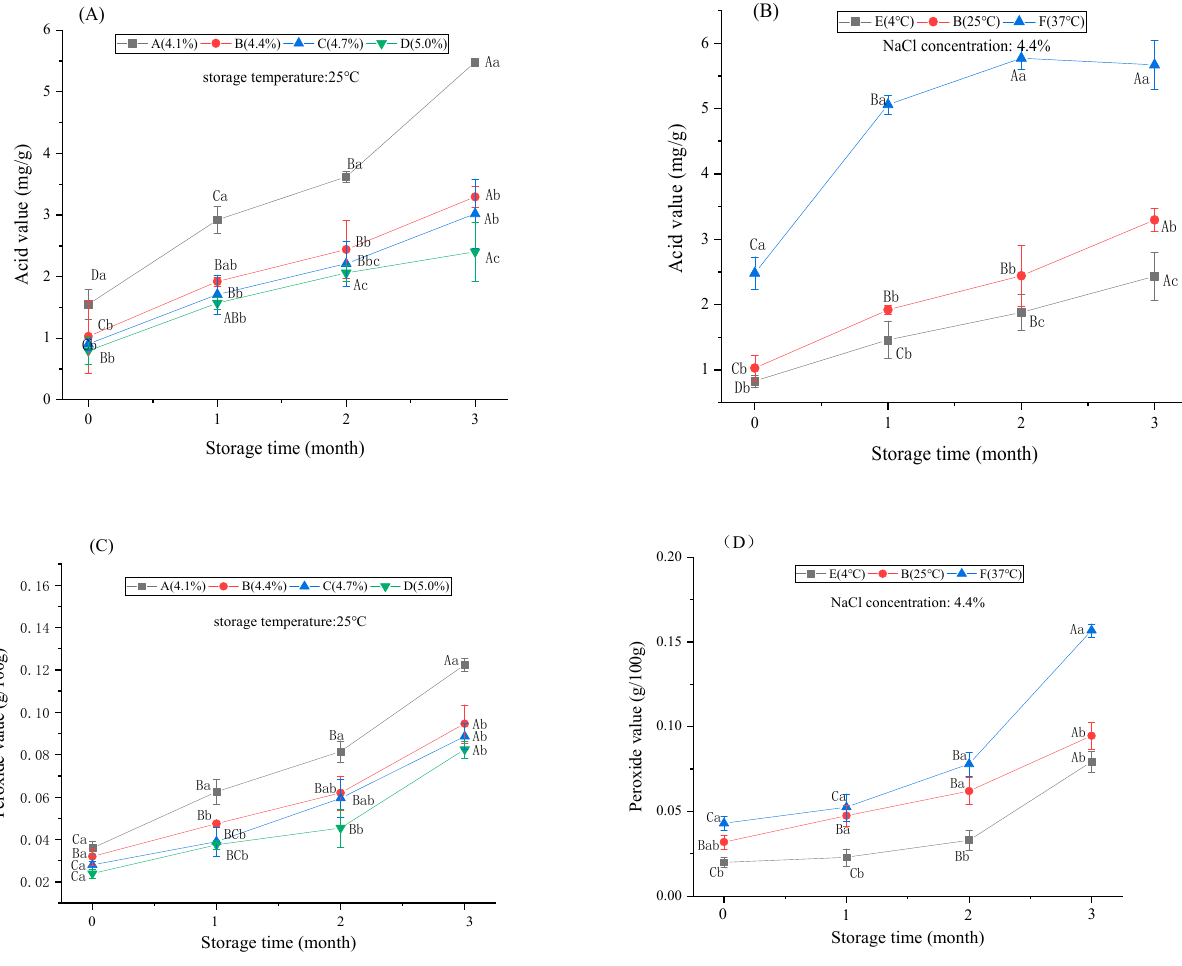
Figure 2. The influence of salt concentration and storage temperature on the AV and POV of hotpot sauce. ( A , C ) Comparison of AV ( A ), POV ( C ) of hotpot sauce with different salt concentrations during storage; ( B , D ) Effects of different storage temperatures on AV ( B ) and POV ( D ) of hotpot sauce. A, B, C, and D represent significant differences in storage time. a, b, c, and d represent significant differences between the different groups.